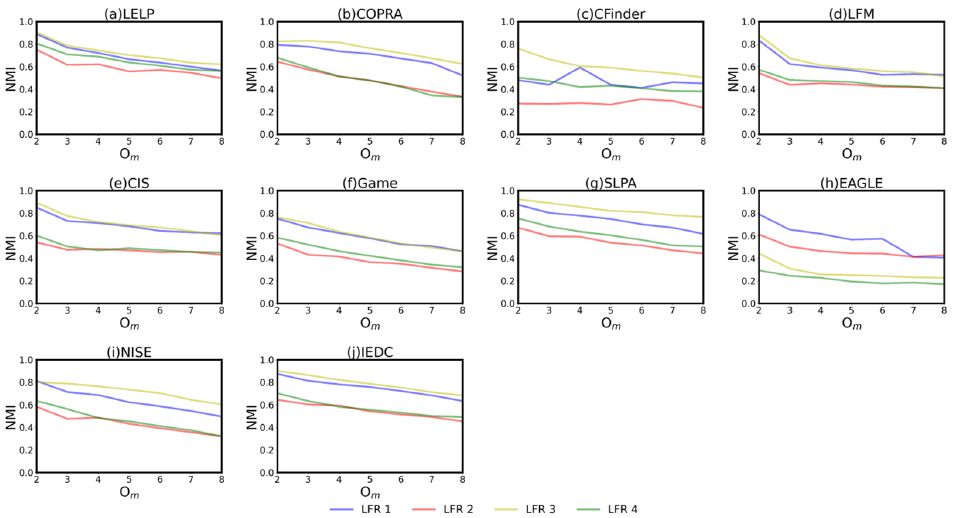
Figure 2. Sub figure ( a – j ) represent the NMI of different algorithms in the LFR 1 to LFR 4, where there are different mixing parameter µ and network size N .